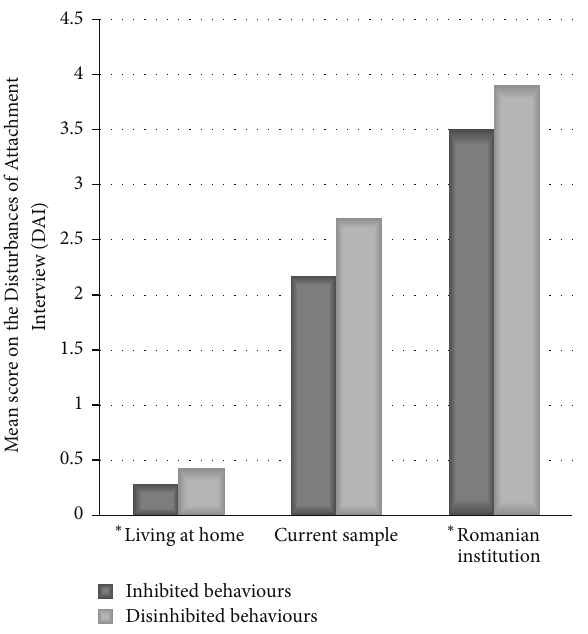
Figure 1: Comparisons of our sample on the Disturbances of Attachment Interview. ∗ Data from